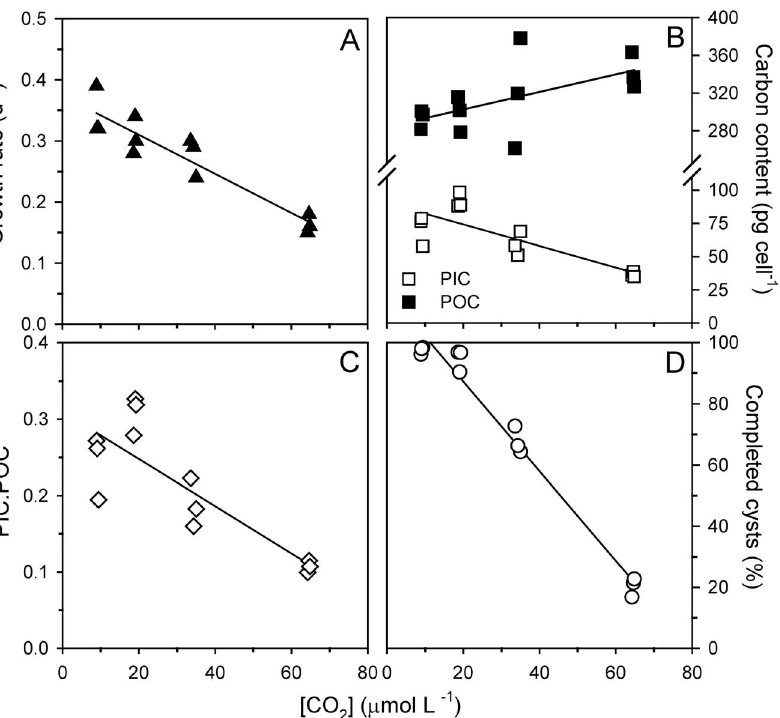
Figure 1. Effect of increasing CO 2 concentrations on growth and calcification. (A) Specific growth rate, (B) PIC and POC, (C) PIC:POC ratio, and (D) fraction of completed cysts. Solid lines indicate linear regressions ( n =12) with (A) R 2 =0.94, P , 0.001, (B) POC: R 2 =0.35, P=0.042, and PIC: R 2 =0.66, P=0.001, (C) R 2 =0.70, P , 0.001, and (D) R 2 =0.98, P , 0.001.